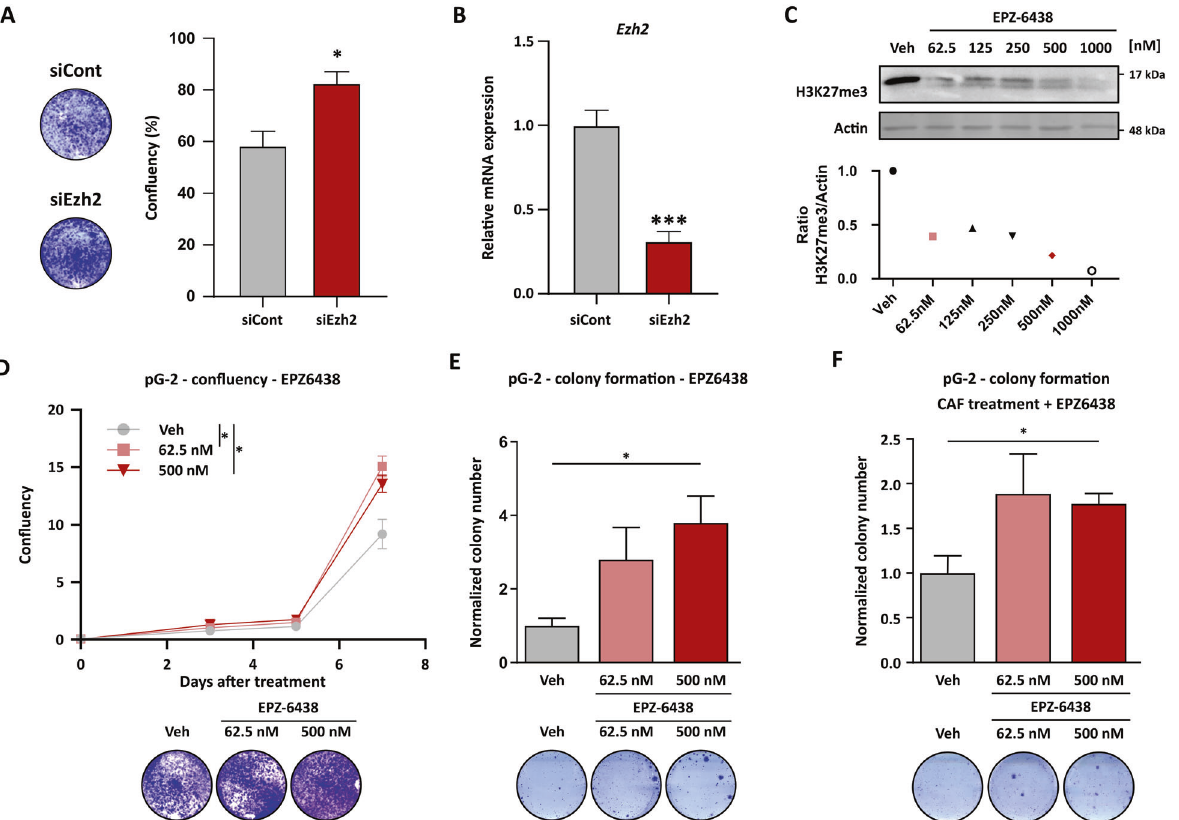
Fig. 3 Reduction of EZH2 activity enhances the aggressiveness of BLBC tumor cells. A Crystal violet staining of pG-2 cells with EZH2 knockdown. The con fl uency was measured by ImageJ and normalized to the controls. B Validation of EZH2 knockdown ef fi ciency via qRT-PCR. Gene expression was calibrated to the control condition (siCont) and normalized to the Rplp0 housekeeping gene. C Measurement of EZH2 inhibition by increasing EPZ-6438 concentration via assessment of H3K27me3 levels in western blots. Densitometry normalized to actin levels is provided in the lower panel. D Proliferation assay of EPZ-6438-treated pG-2 cells using celigo ® and crystal violet staining. E and F Colony formation assay upon treatment of pG-2 cells with EPZ-6438 alone ( E ) or in combination with CAF ( F ). The number of colonies was assessed through ImageJ analysis. Error bars: standard error of the mean (SEM). * p -val ≤ 0.05, ** p -val ≤ 0.01, *** p -val ≤ 0.005. Student ’ s t -test: A and B one-way ANOVA: D – F All experiments were performed in biological triplicates ( n =